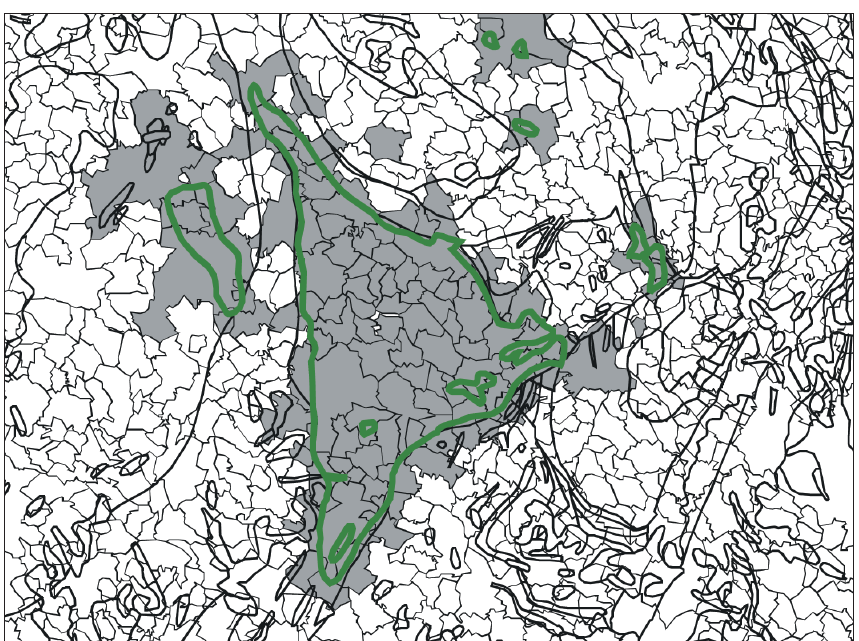
Fig. 1. The selection of cadastres performed by simple intersection of cadastres and contours of durbachite bodies (bold